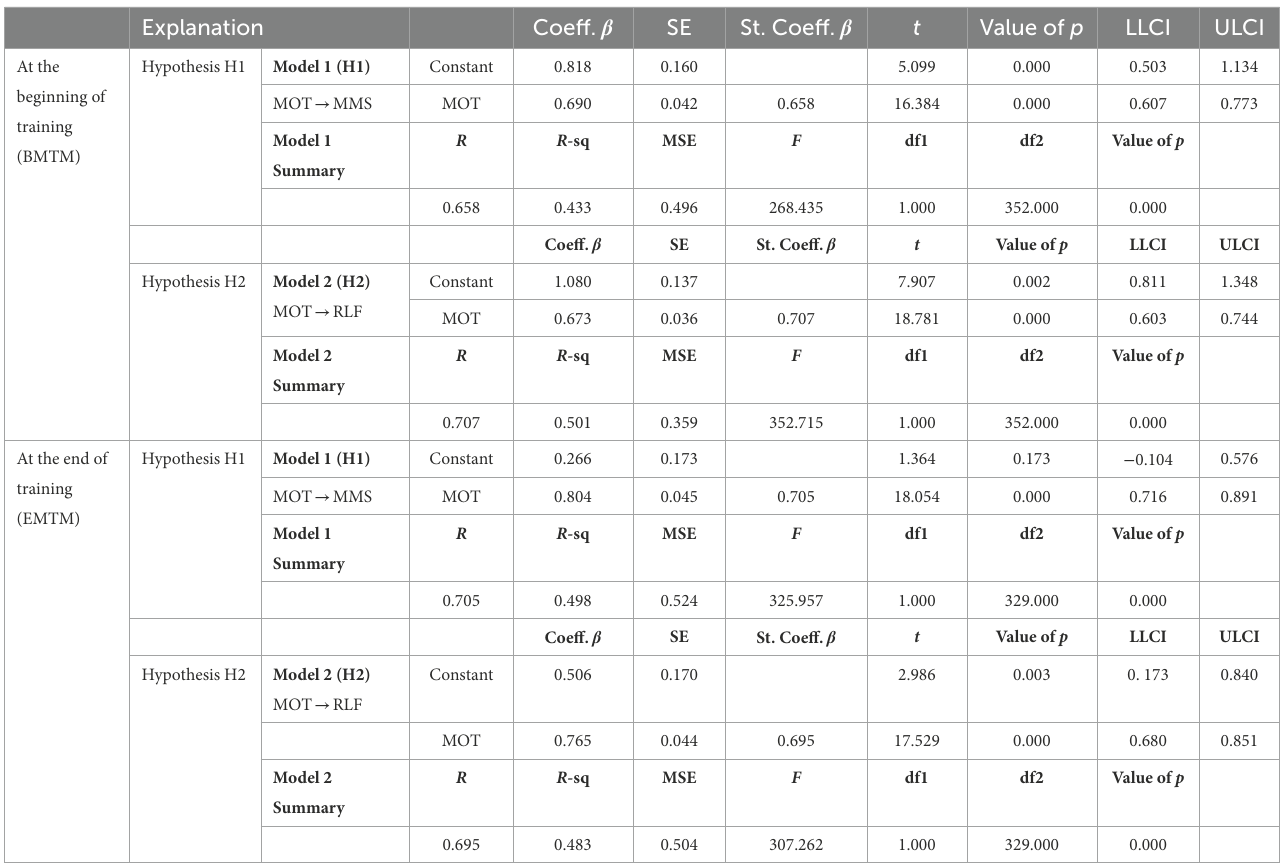
TABLE 4 The direct effects of Prosocial Motivation (MOT) evaluated by using the PROCESS v3.5 macro-Model 4. Explanation Coeff. β SE Hypothesis H1